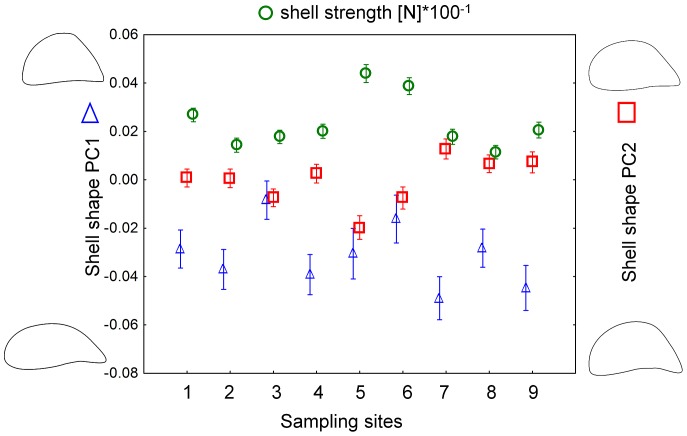
Field data reveal high phenotypic diversity in zebra mussels.Mean (±SE) shell shape (triangles = PC1, squares = PC2) and shell strength (filled circles) of 84 mussels from each of 9 sampling sites. The contours on both y-axes depict ±2SD of the mean of PC1 and PC2.